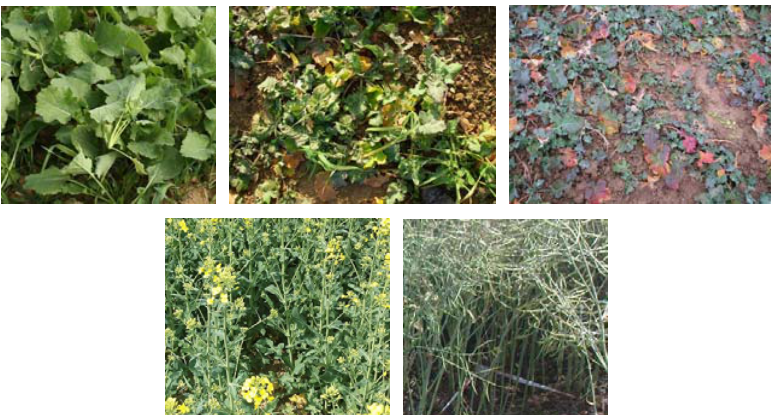
Figure 5. Photographs of the winter rape canopy demonstrating stages of phenology at the beginning of October (top left), middle of November(top centre) and middle of December (top right) as well as May (bottom left) and July (bottom